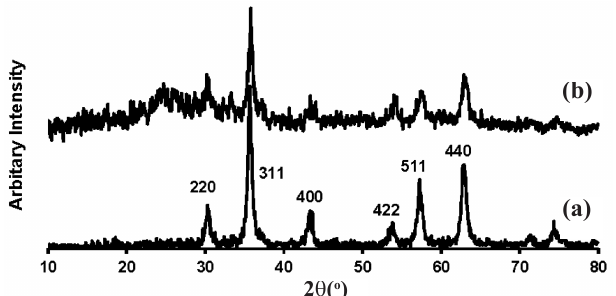
Fig. 2. XRD patterns of (a) Fe 3 O 4 and; (b) Fe 3 O 4 @ZrO 2 -SO 3 H